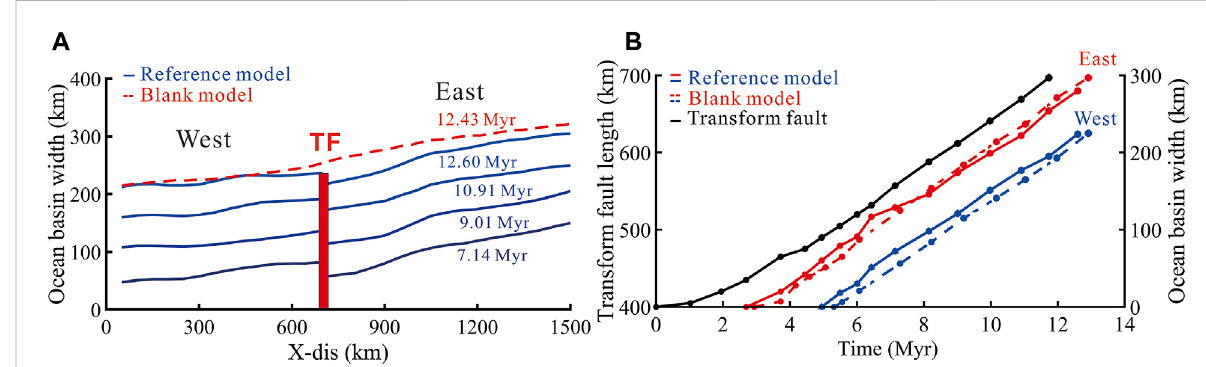
FIGURE 7 Evolution of sea basin width and transform fault length. (A) Evolution of the oceanic basin width with along-strike variations. The red bar represents the transform fault location. (B) Evolution of basin expanding and transform fault growth (basin width is computed in the middle of each basin